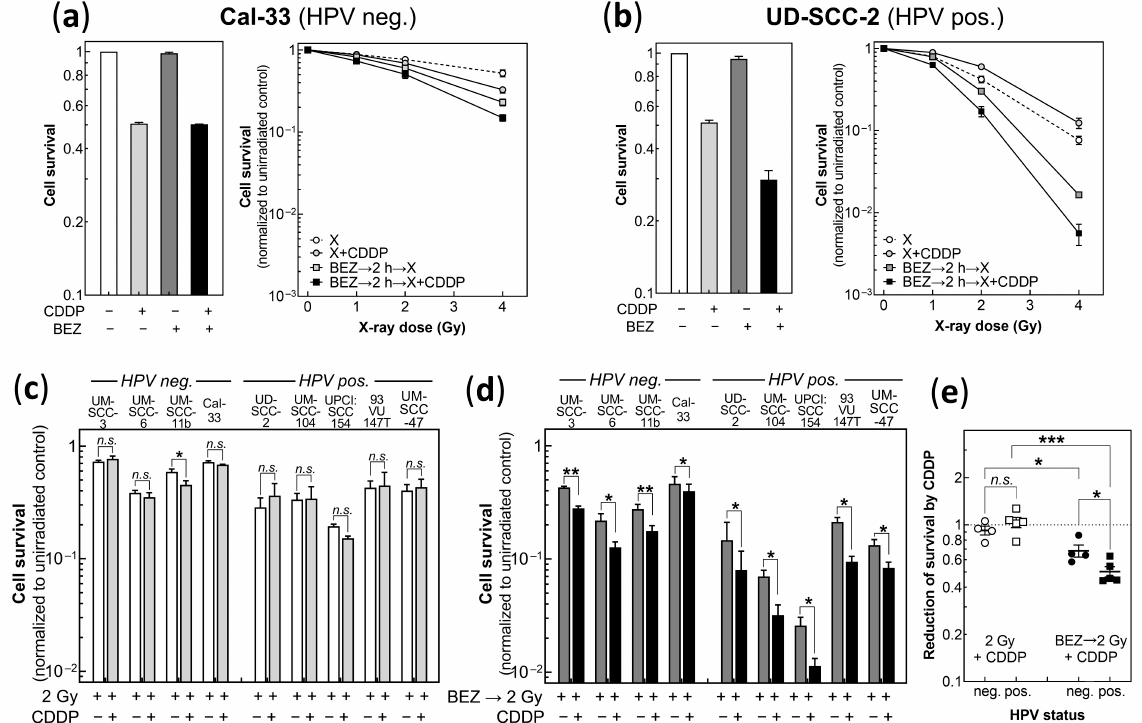
Figure 4. Effect of BEZ235 on the combined treatment of HPV neg. and HPV pos. HNSCC cell lines with cisplatin and radiation. Cells were pretreated with 50 nM BEZ235 (BEZ) for 2 h before irradiation (X) and incubation with cisplatin (CDDP) using the respective IC50, followed by a medium change after 24 h for colony formation. ( a ) Effect on the HPV neg. cell line Cal-33, and ( b ) on the HPV pos. cell line UD-SCC-2. ( c ) Effect of cisplatin on cell survival at 2 Gy without and ( d ) with pretreatment by BEZ235. Survival was normalized to the non-irradiated cells. ( e ) Relative effect of cisplatin on survival at 2 Gy obtained by normalizing to respective survival after 2 Gy alone, without or with pretreatment with BEZ235. Data are presented as mean values ± SEM, n ≥ 3, * p = 0.05; ** p = 0.001, *** p = 0.0001, n.s. : non significant.